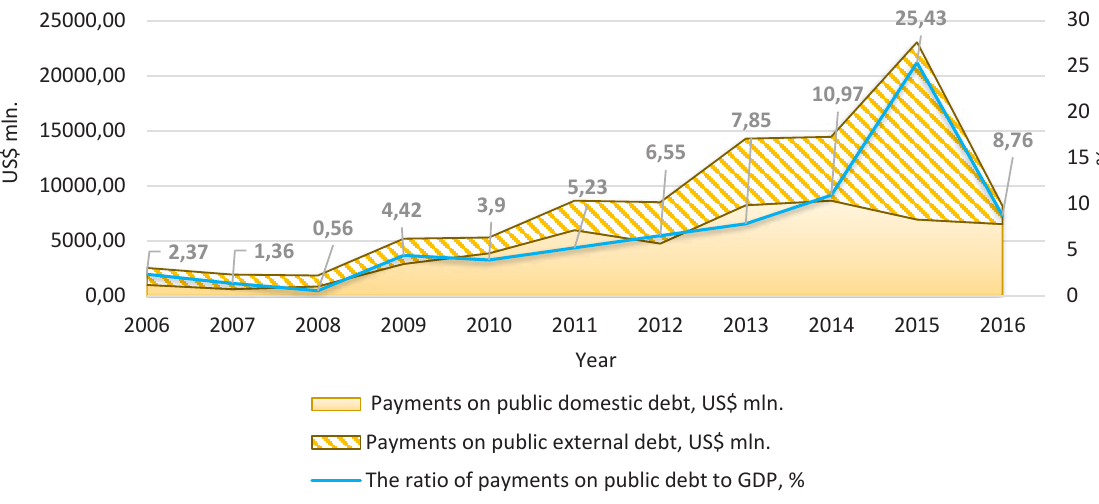
Figure 4. The dynamics of the payments on public domestic debt, payments on the public external debt and the ratio of payment on public debt to GDP in Ukraine,